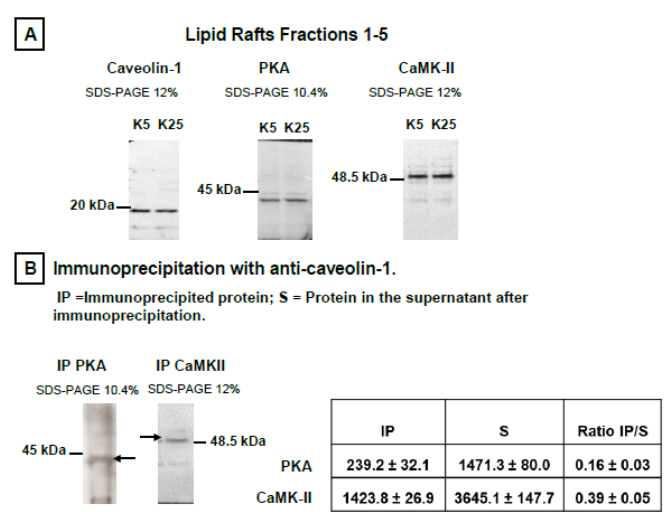
Figure 2. Protein kinase A (PKA) and calmodulin-dependent protein kinase II (CaMK-II) are associated with lipid rafts isolated from mature CGNs in culture. The presence of PKA and CaMK-II in lipid raft membrane fractions was determined by Western blotting using rabbit anti-PKA (sc-28892) and rabbit anti-CaMK-II (sc-9035), with rabbit anti-caveolin-1 (sc-894) for the lipid raft protein marker caveolin-1. Fractions 1–5, which are enriched in lipid raft marker proteins caveolin-1 and H-Ras, are also enriched in cholesterol, as shown in previous works by our laboratory [8–10]. ( A ) PKA and CaMK-II are present in fractions 1–5 where lipid raft markers are also enriched, both in CGN survival medium MLocke’s K25 and also after 1 h incubation at 37 ◦ C in a 5% CO 2 culture chamber in proapoptotic MLocke’s K5 medium. The Western blot images shown are representative of the results obtained in experiments done with at least three different preparations of lipid rafts, as indicated in Materials and Methods. The same amount of lipid raft protein, 5 µ g, was loaded into each lane in these experiments. The position of the molecular weight marker bands closest to the target proteins of the primary antibodies, i.e., caveolin-1 (~20 kDa), CaMK-II (~50 kDa), and PKA (~40 kDa), are shown at the left or right side of the corresponding PVDF membrane images. ( B ) Results of immunoprecipitation of cell lysates with caveolin-1, performed as indicated in Materials and Methods. The fraction of PKA and CaMK-II immunoprecipitated with caveolin-1 was calculated from a densitometry analysis of their bands in the Western blots and revealed using the primary and secondary antibodies indicated above, taking into account that while all precipitated samples were loaded into the corresponding lanes of the SDS-PAGE gels (IP), only a fraction of the total supernatant volume (S) was loaded into the gel lanes. The results shown in the table inserted in this panel are the average ± S.E. of triplicate experiments.